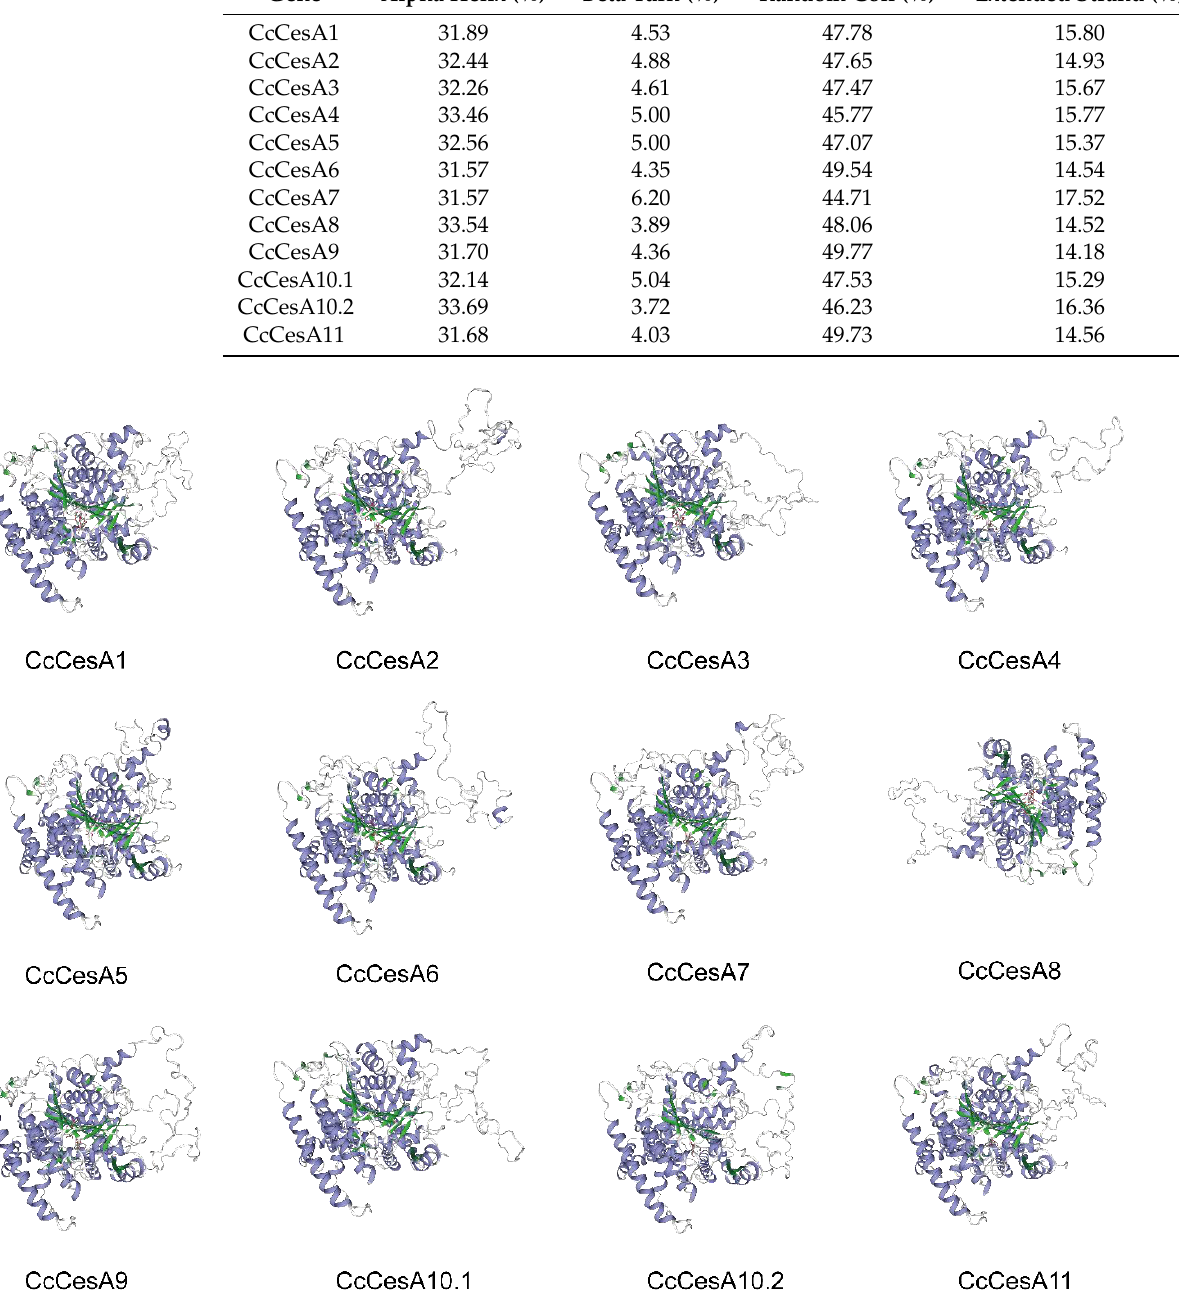
Figure 6. Protein tertiary structure prediction of